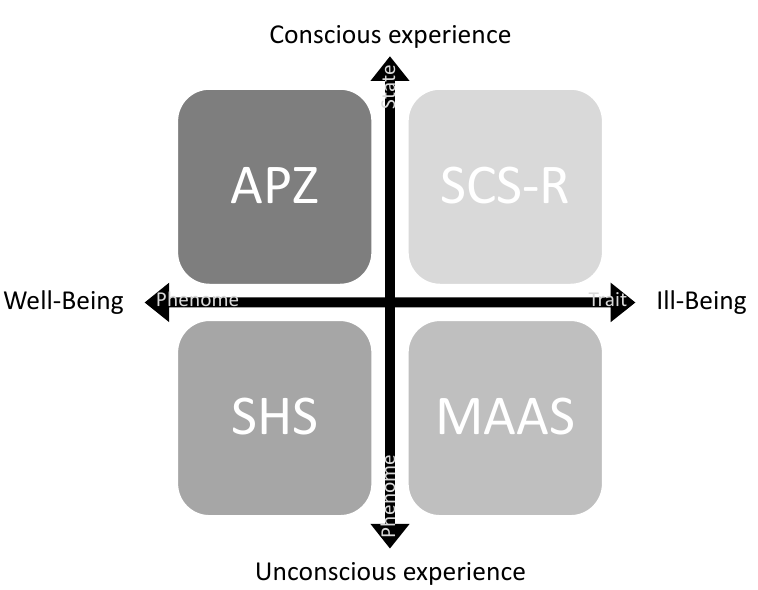
Figure 7. Neurophenomenological sampling and subgroup identification: Psychological Scales. A two-axis plot represents the mental health profiling and the four instruments used for the clinical stratification. The vertical axis represents the constructs of a more self-conscious experience vs. a less self-conscious experience. The horizontal axis represents the complementary constructs (postulated in this study) of a higher tendency to well-being vs. a lower tendency to